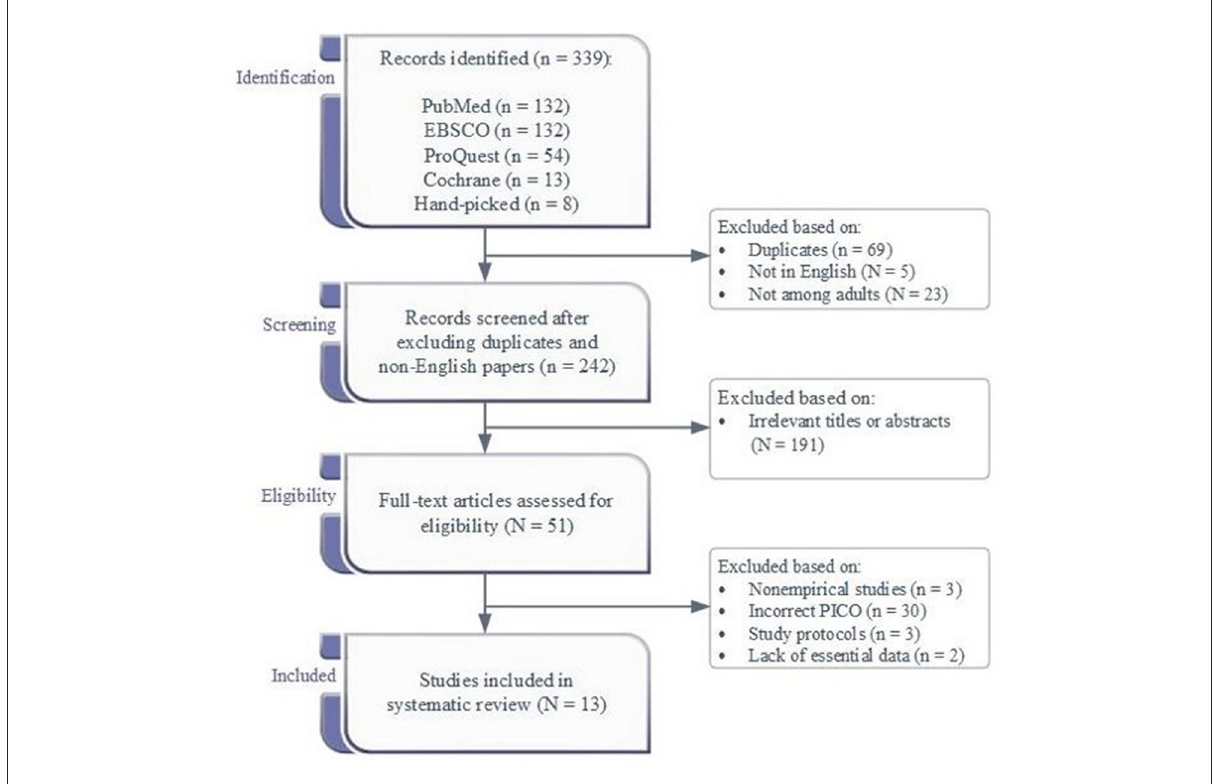
FIGURE1 The process diagrammatically study